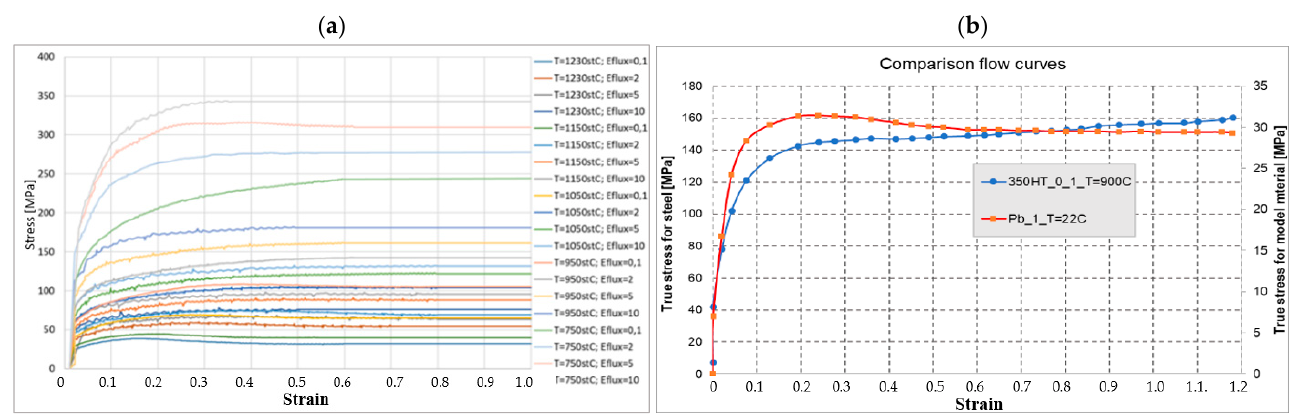
Figure 8. Selection of the model material Pb for R350HT steel: ( a ) the flow curves for R350HT steel, ( b ) a comparison of the flow curves for selected dominating deformation conditions.